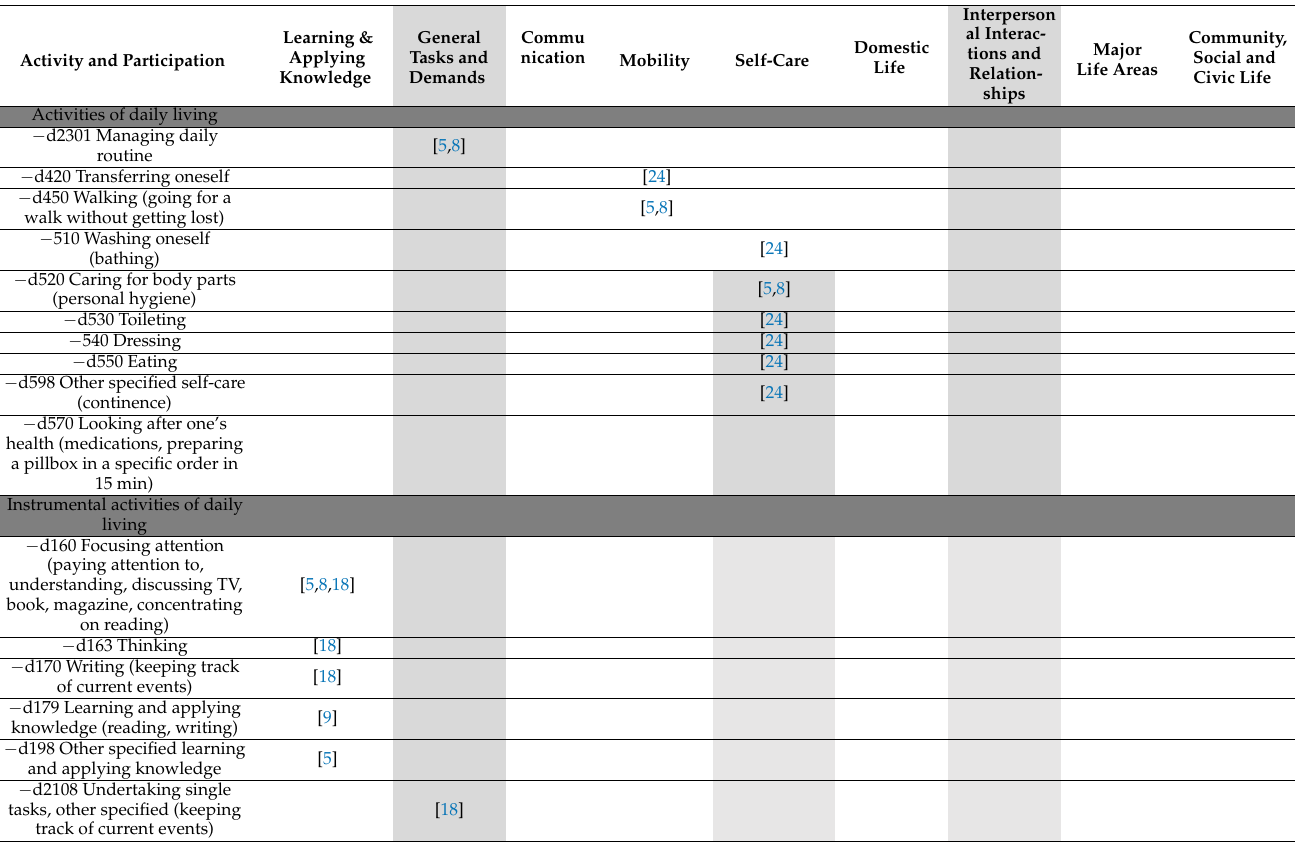
Table 4. ADL/IADL indicators of subjective cognitive decline framed on ICF framework and coding